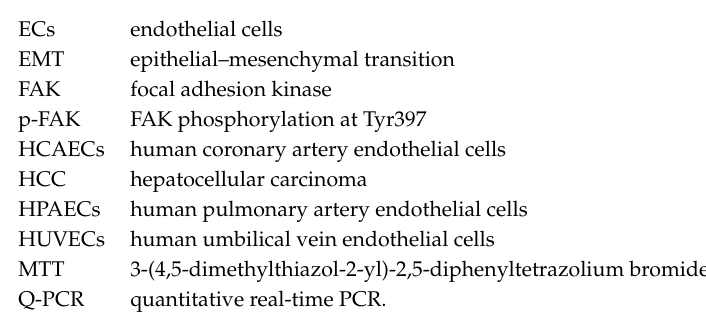
Figure S1: Structure of cordycepin and adenosine, Figure S2: Cordycepin has no significant effect on inducing HUVEC apoptosis, Figure S3: Cordycepin suppresses FAK expression and phosphorylation in HCC, Figure S4: Cordycepin inhibits cell proliferation of HCC, Figure S5: Representative immunohistochemistry staining of CD31 in tumors of xenograft nude mice treated without or with cordycepin, Table S1: Culture medium of HUVECs, HCAECs and HPAECs, Table S2: Antibodies used in this study; Table S3: Primer sequences for Q-PCR used in this